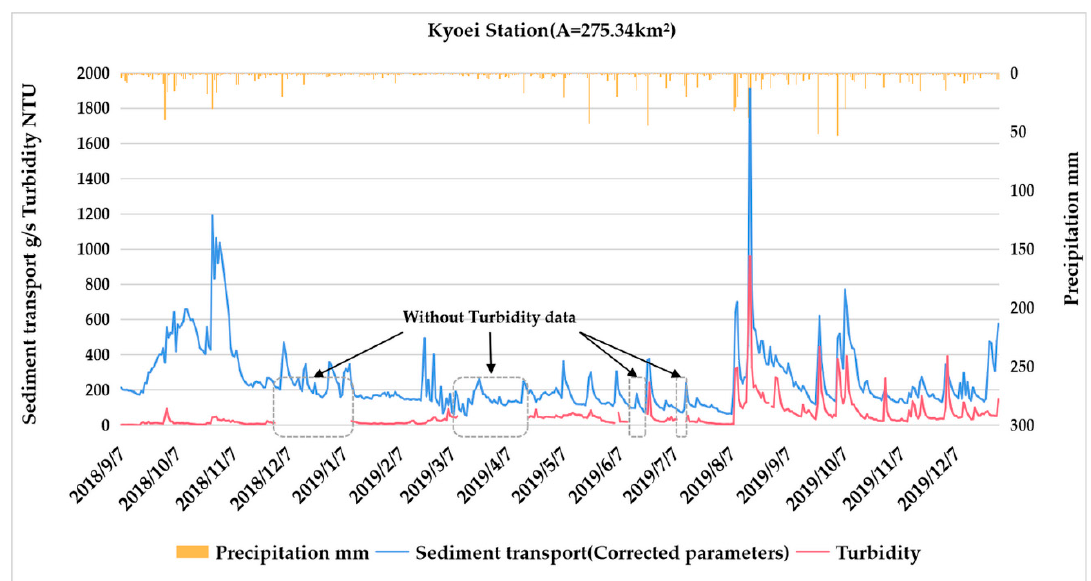
Figure 8. Comparison of turbidity and sediment transport (corrected parameters) after 2018 Hokkaido Eastern Iburi Earthquake at Kyoei station.